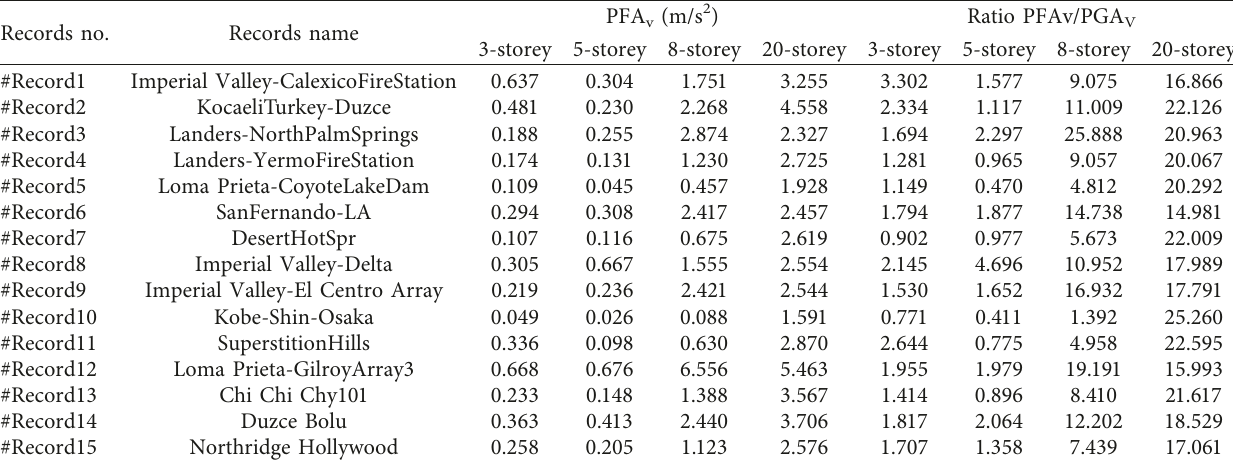
Table 10: Ratios of PFAv/PGAv for the far-field